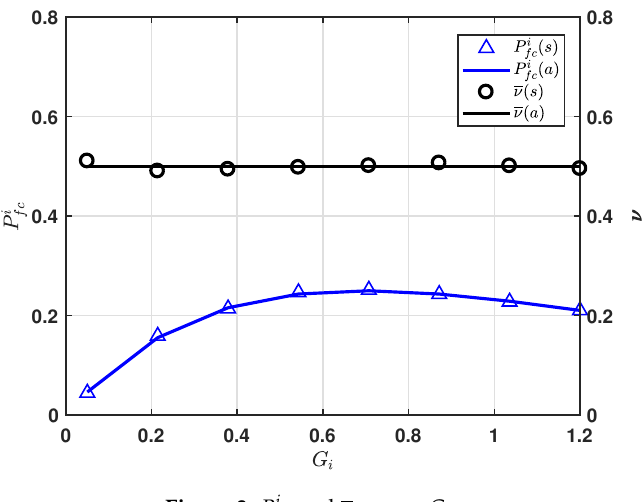
and ν versus G i fc